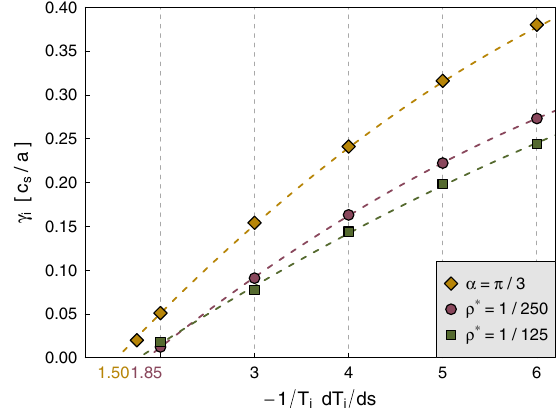
FIG. 6. Scaling of the ion heat flux (in gyroBohm units) caused by ITG turbulence on the magnetic surface of the QUASAR stellarator and the tokamak in the two ρ (cid:3) regimes. Also shown is the curve corresponding to the local turbulence at the most unstable field line with α ¼ π = 3 on the magnetic surface of QUASAR. The established upshift (about 15%) is due to the turbulence averaging on the surface.